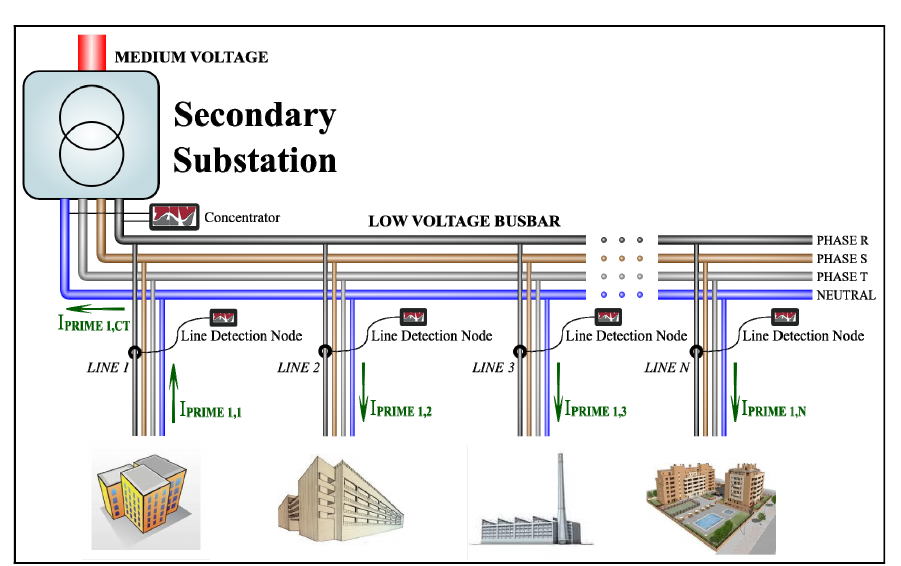
Figure 5. Line detection nodes deployed in a LV